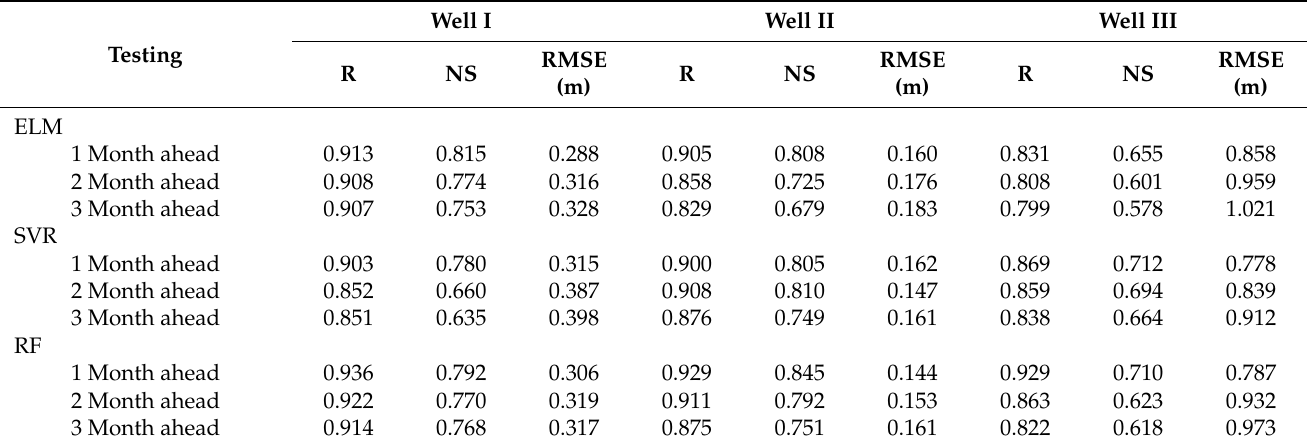
Table 2. The performance metrics of the standalone ELM, SVR, and RF models for 1-, 2-, and 3-month-ahead GWL predictions for Wells I, II, and III in the testing periods.